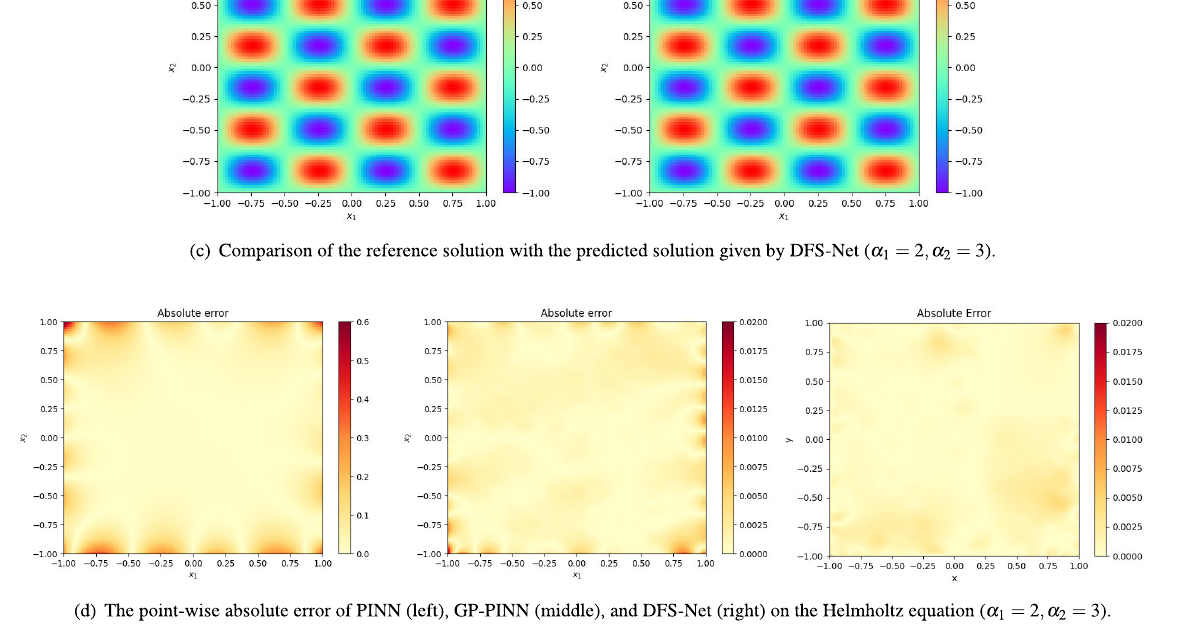
Figure 4. Performance of different surrogate models on the Helmholtz